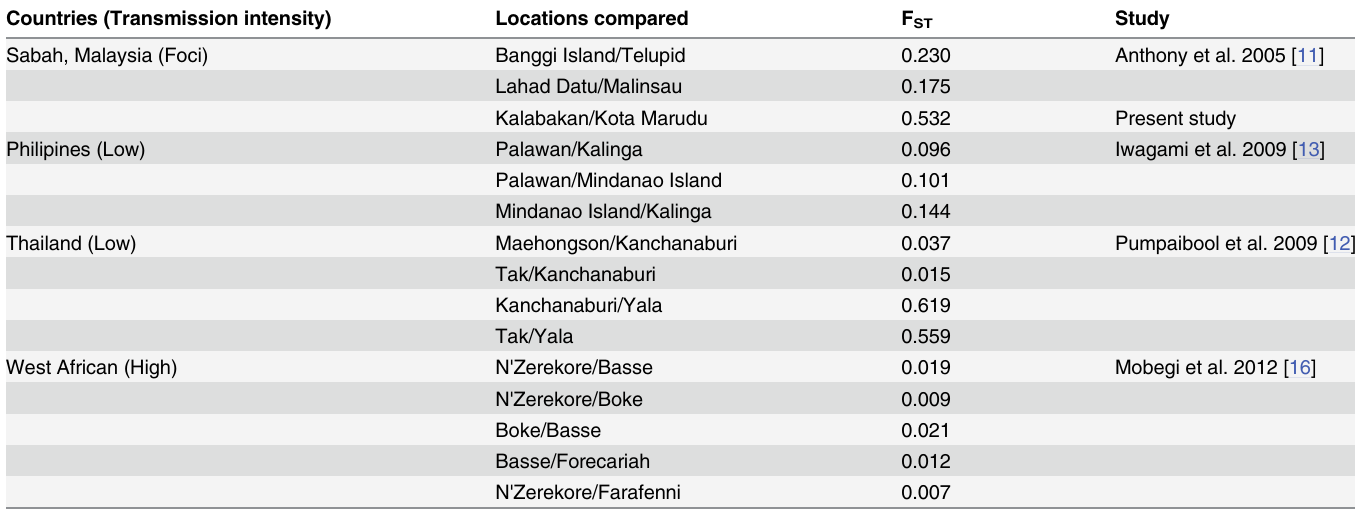
Table 10. Interpopulation comparison of F ST between P . falciparum from Asian and other countries with different transmission intensity. Countries (Transmission